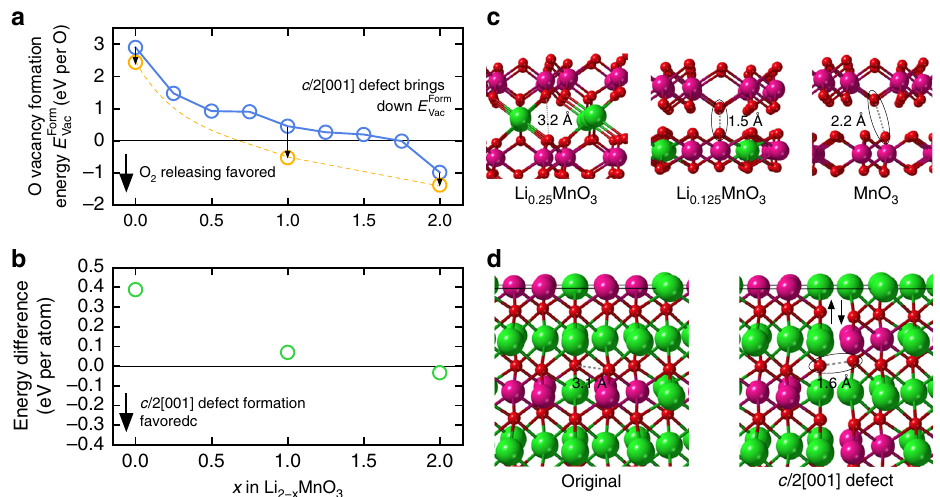
Fig. 4 The impact of defect formation on oxygen loss during delithiation of Li 2 MnO 3 . a Calculated O vacancy formation energy as a function of Li removal before and after c /2[001] defects are introduced to the system. b Energy difference between Li 2 MnO 3 structures with and without c /2[001] defects. c Oxygen – oxygen interactions in Li 2 − x MnO 3 systems without defects. d Oxygen – oxygen interactions in systems with c /2[001]